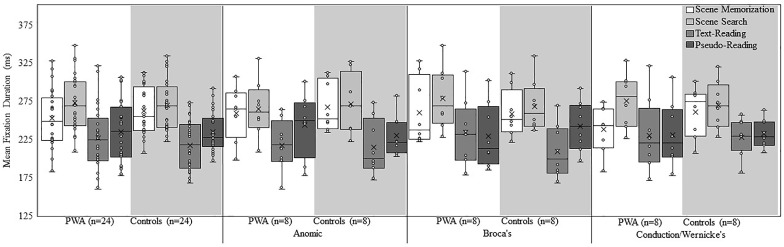
Box and whisker plot of mean fixation duration for each participant group, subtype, and task. The middle line of the box represents the median. The x represents the mean and each participant is represented by a circle. The bottom line of the box represents the median of the 1st quartile, and the top line represents the median of the 3rd quartile. The whiskers represent the minimum and maximum values, with outliers as values that exceed 1.5 times the interquartile range (IQR) below the 1st quartile or 1.5 times the IQR above the 3rd quartile. The IQR is the distance between the 1st quartile and the 3rd quartile.